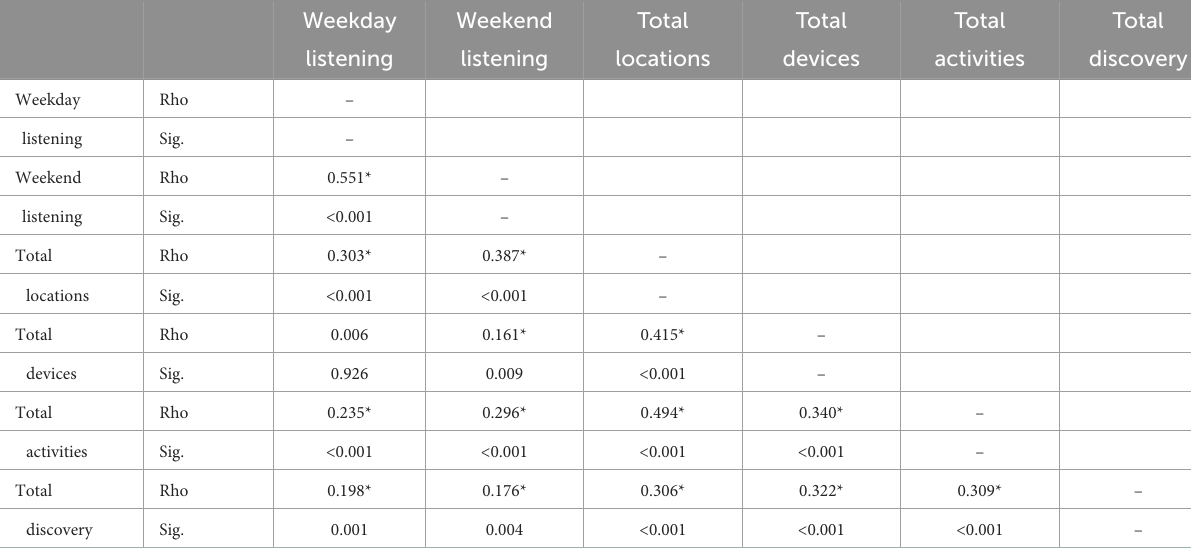
TABLE 9 Spearman’s rank-order correlations amongst the aspects of podcast listening engagement ( N = 264).